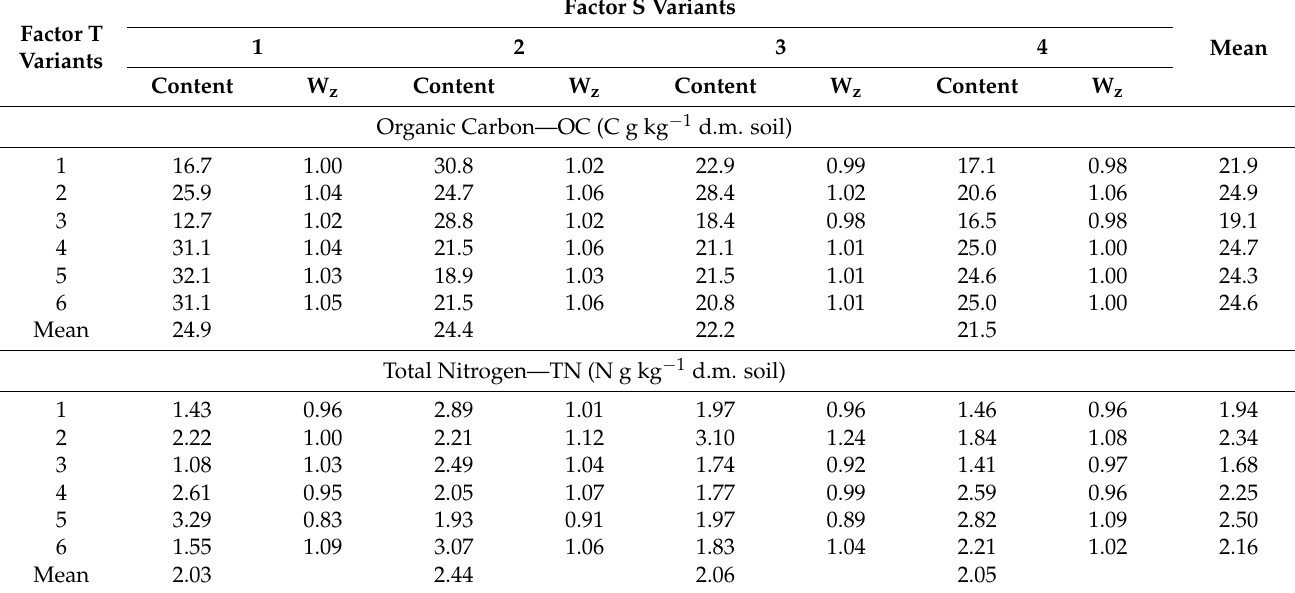
Table 1. Soil organic carbon OC and total nitrogen TN (g kg − 1 ) content, depending on the tillage method (factor T) and stubble management (factor S) in spring wheat